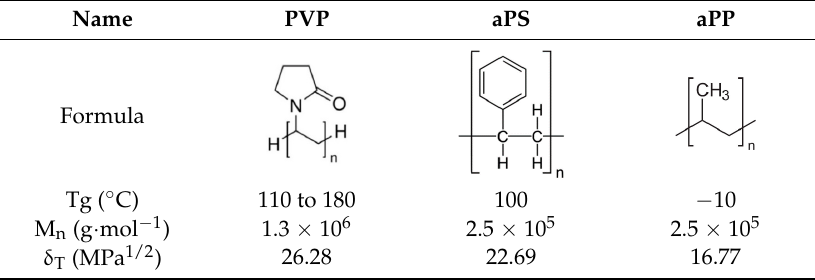
Table 1. Some characteristics of quantum resistive vapor sensors (vQRS) polymer matrices. PVP: poly(vinylpyrrolidone); aPS: amorphous poly(styrene); aPP: amorphous poly(propylene).